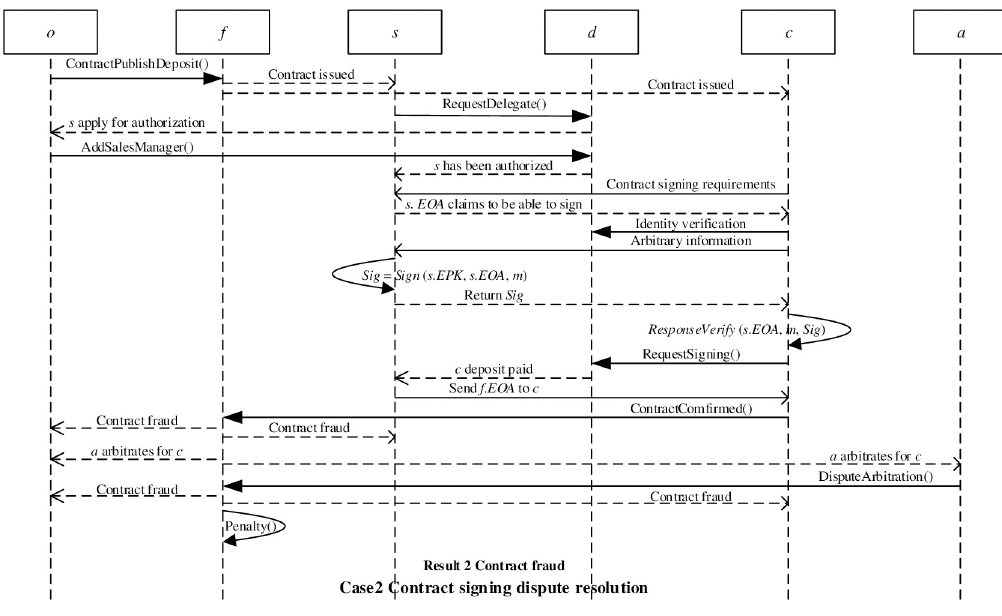
Fig 7. Contract fraud dispute